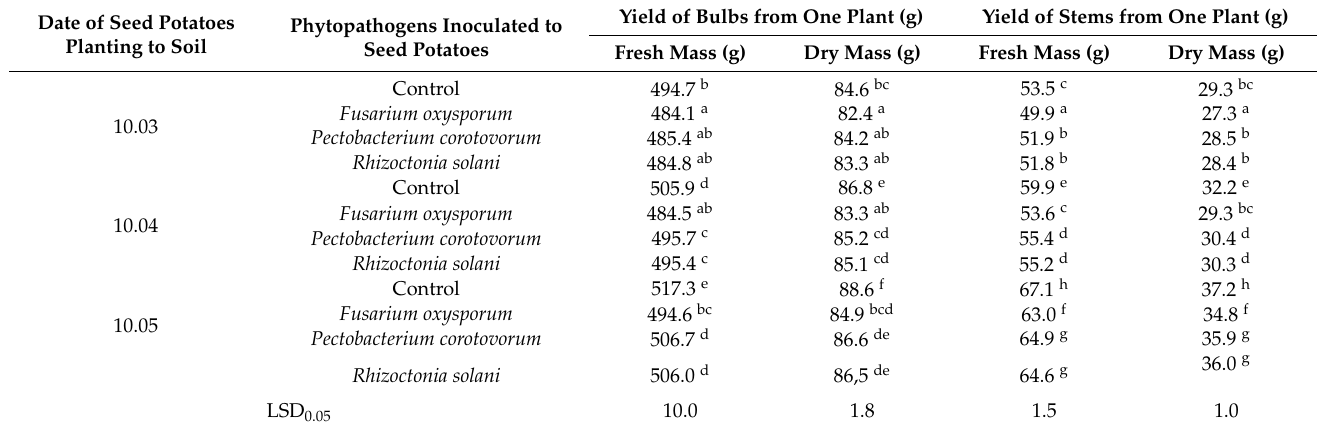
Table 4. Fresh and dry weight of tubers and dried stems per plant, obtained from the seed potatoes stored at 4 ◦ C from harvest until inoculation with phytopathogens on 10 February and then at 15 ◦ C and 80% RH before planting in the soil on 10 March, 10 April, and 10